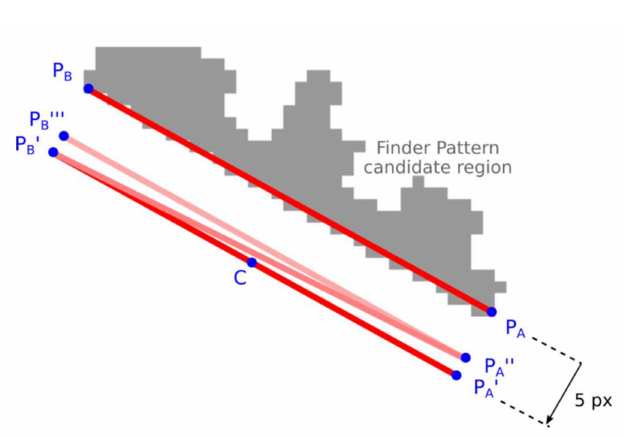
Figure 11. Approaching the line segment to the region.